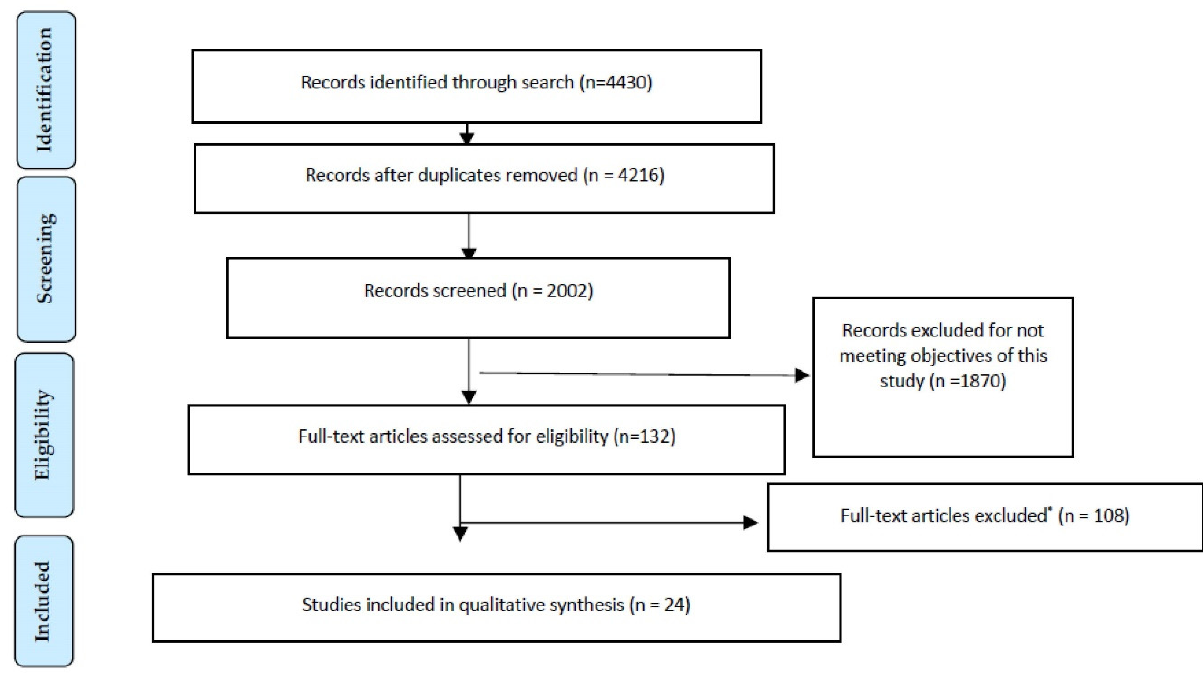
Figure 1. PRISMA flow diagram for studies retrieved through the searching and selection process. * Reasons for exclusion of articles are presented in the Materials and Methods section.